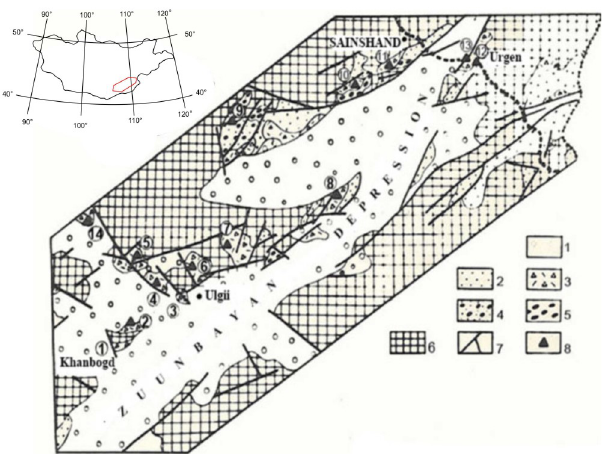
Fig. 4. Zuunbayan depression geology and zeolites